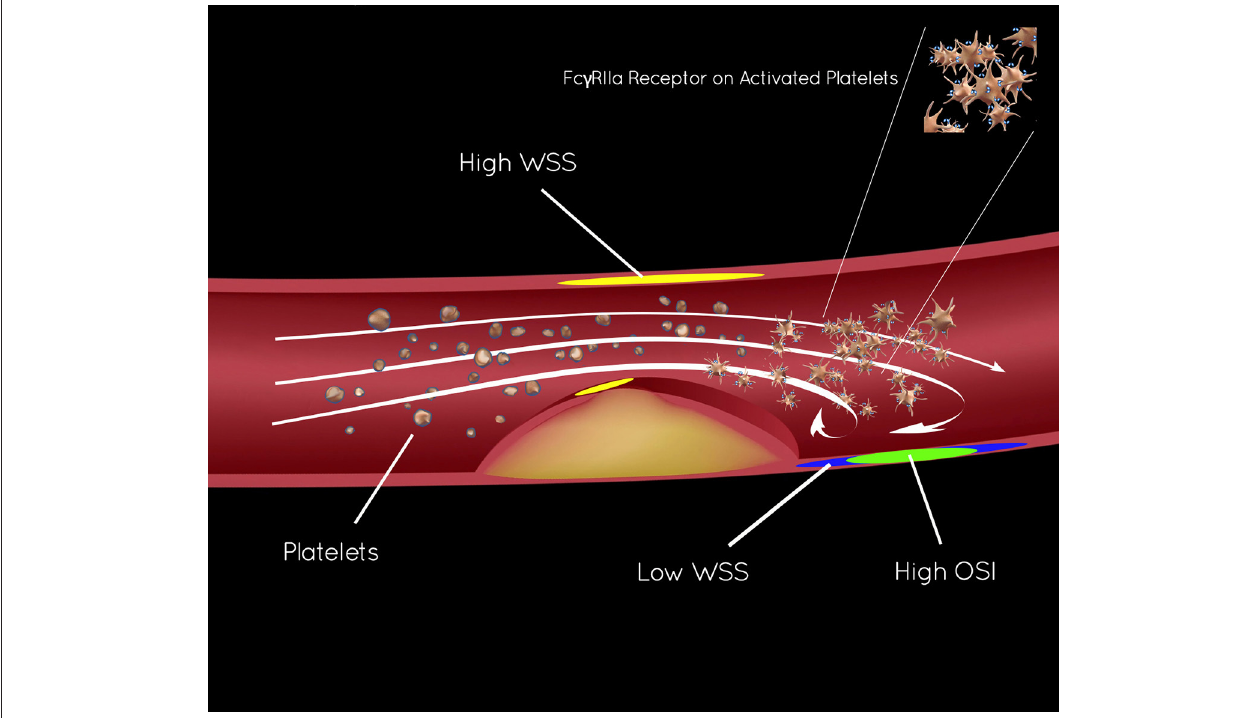
FIGURE 1 | Endothelial shear stress in ICAD and activation of platelet Fc γ